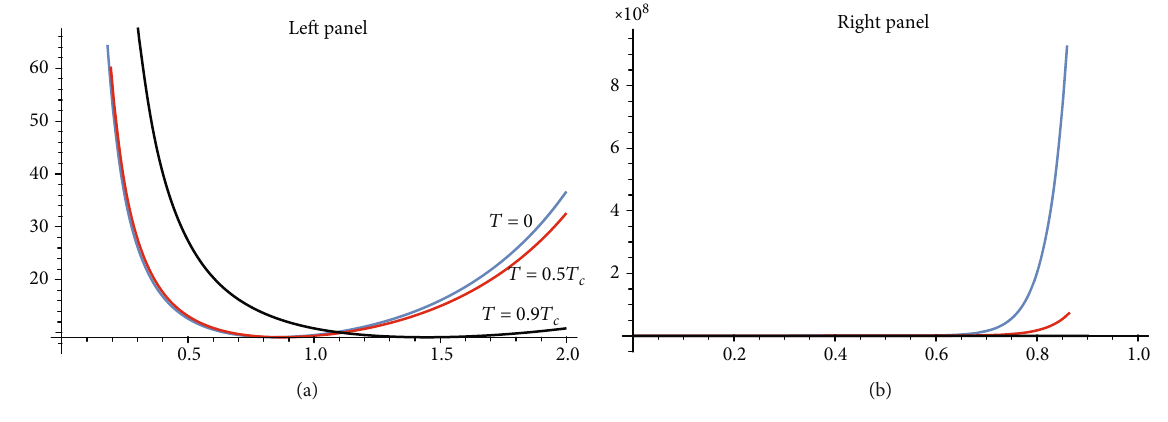
Figure 8: A graph of scalar potential energy, S ð r , T Þ , against r , T for m